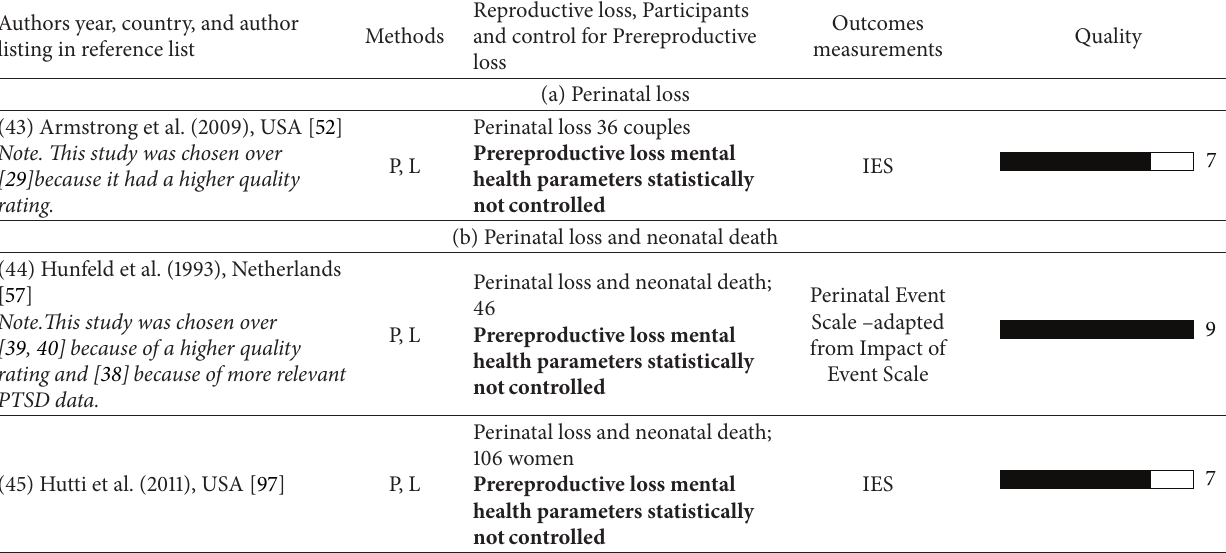
Table 3: Characteristics of included studies for perinatal loss (a) and perinatal loss with neonatal death